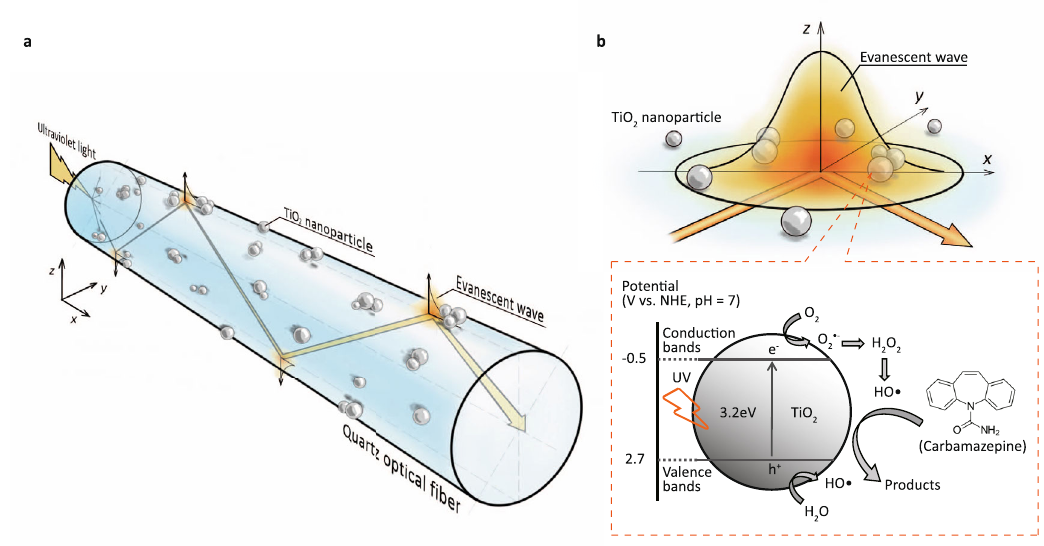
Fig. 1 Schematics of the TiO 2 -QOFs with tunable surface “ patches ” of TiO 2 layers. a Light propagates along the TiO 2 -QOFs and generates evanescent waves when light strikes the optical fi ber surfaces without TiO 2 nanoparticles; and b TiO 2 nanoparticle activation by the generated evanescent waves, and the subsequent production of hydroxyl radicals (HO • ) to degrade